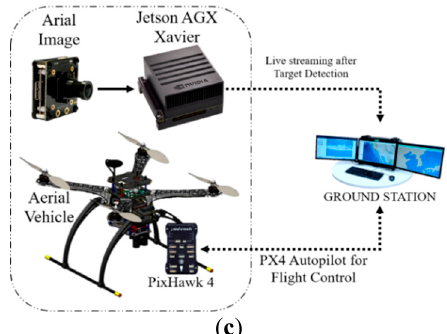
Figure 5. ( a ) On-board target detection system using Jetson TX1, ( b ) On-board target detection system using Jetson TX2, and ( c ) On-board target detection system using Jetson AGX Xavier.